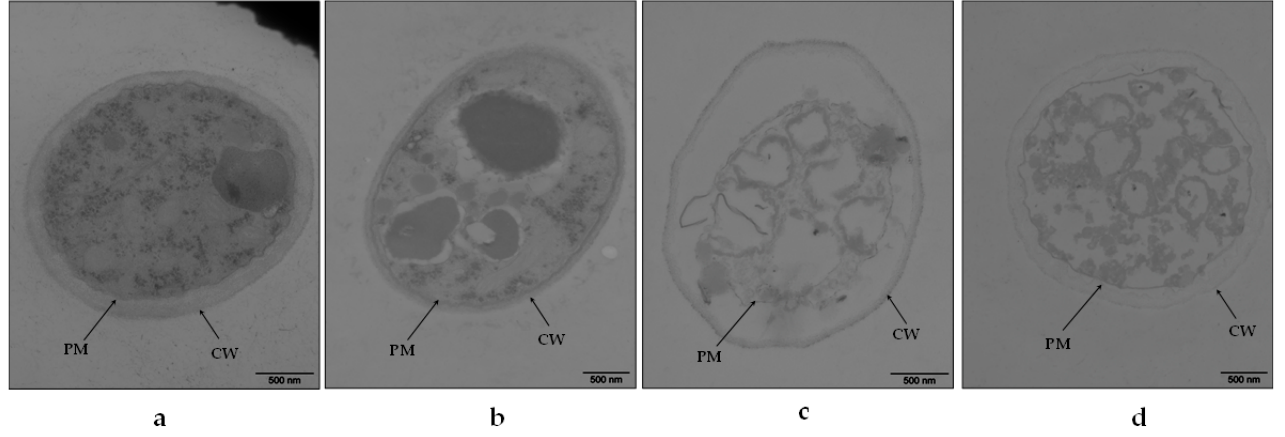
Figure 2. Transmission electron microscopy (TEM) image of Botrytis cinerea mycelium exposed to control ( a ), Cymbopogon citratus ( Cc , b ), Thymus vulgraris ( Tv , c ), and Origanum heracleoticum ( Oh , d ) essential oil. Bar = 500 nm. CW, cell wall; PM, plasma membrane.